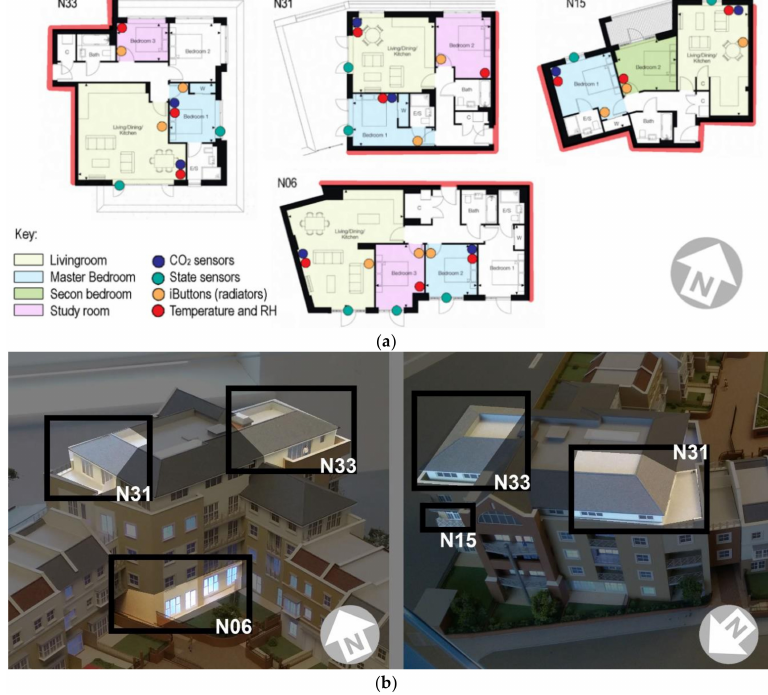
Figure 2. ( a ) Plans and data logger locations; ( b ) flat positions in